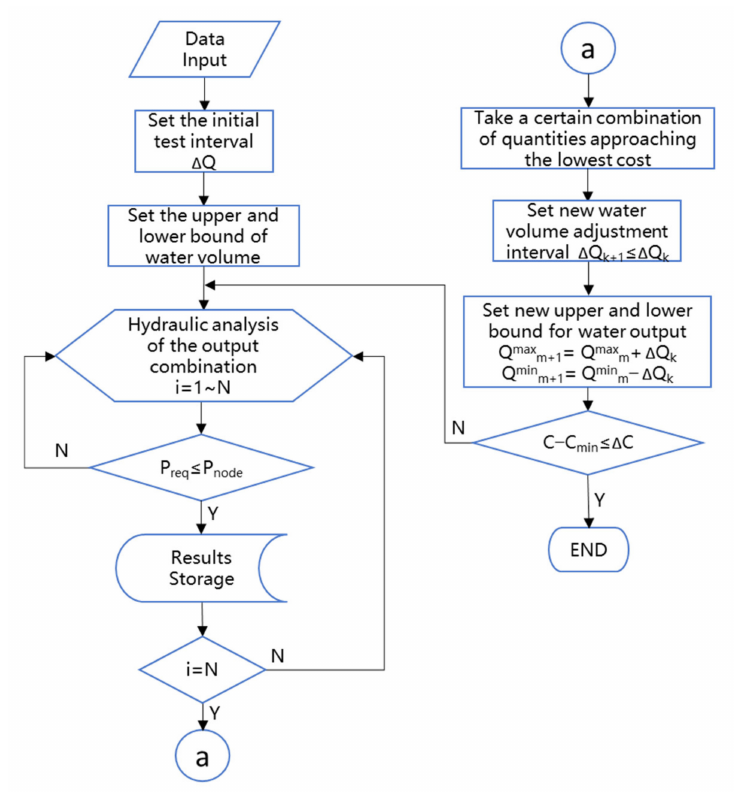
Figure 2. UGSP flow